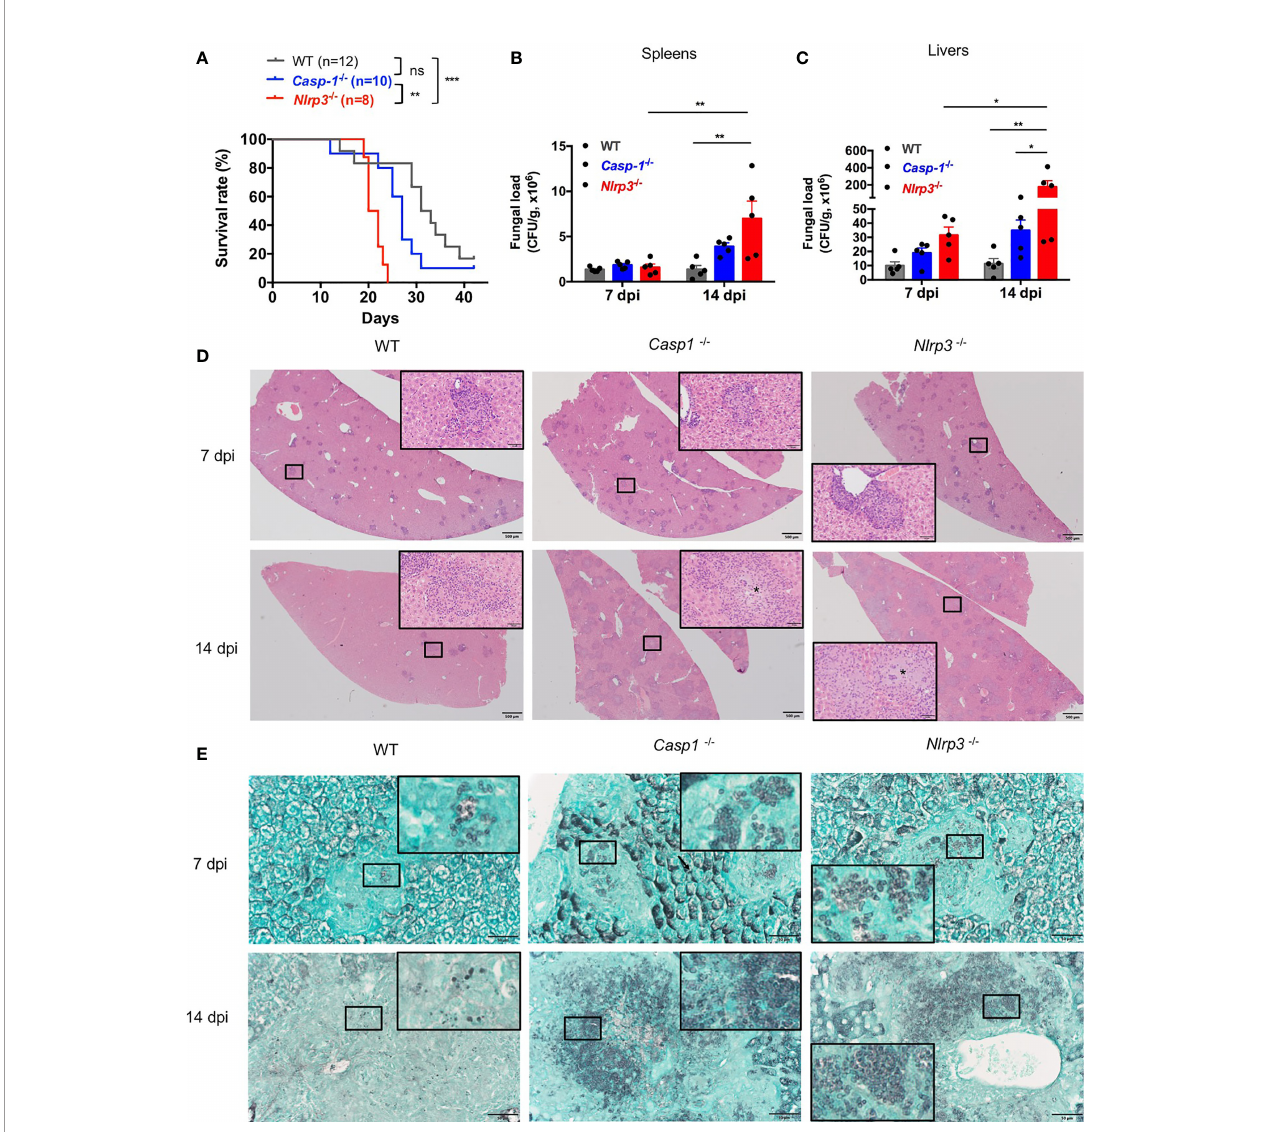
FIGURE 5 | The NLRP3 in fl ammasome controls antifungal immunity in vivo . (A) Survival plot of WT, Casp-1 -/- and Nlrp3 -/- mice intravenously injected with live T. marneffei yeasts (5x10 5 CFU per mouse). (B, C) Fungal load analyses of spleens and livers of WT, Casp-1 -/- and Nlrp3 -/- mice infected with live T. marneffei yeasts at 7 and 14 days post infection (dpi). (D) Representative HE staining graphs of murine livers of WT, Casp-1 -/- and Nlrp3 -/- mice infected with live T. marneffei yeasts (n=4). Scale bar denotes 500 m m. The insets indicate the magni fi ed area of the smaller box containing granulomas, and the asterisk indicates massive fungal yeasts in the granulomas. (E) Representative GMS staining graphs of murine livers of WT, Casp-1 -/- and Nlrp3 -/- mice infected with live T. marneffei yeasts (n=4). Scale bar denotes 50 m m. The insets indicate the magni fi ed area of the smaller box containing T. marneffei yeasts. The log-rank tests are performed when compared the survival rates between groups (A) . Data are depicted as mean ± SEM of n=5 mice and are analyzed by two-way ANOVA (B, C) . ns, not signi fi cant. *p < 0.05, **p < 0.01, ***p <